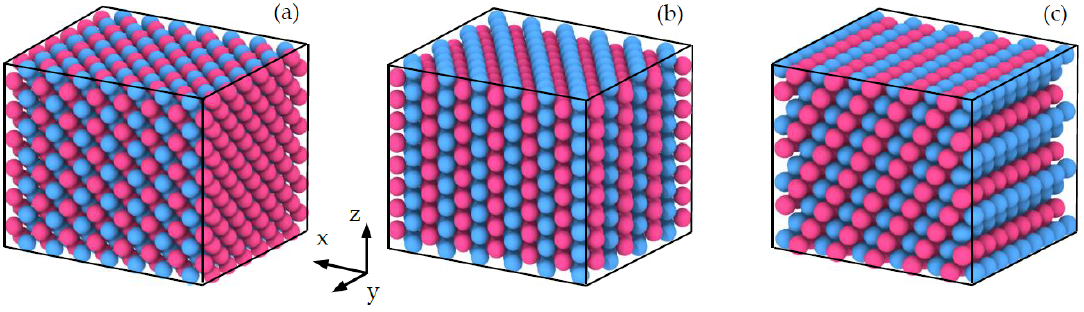
Figure 1. Nanoindentation model of  -TiAl.